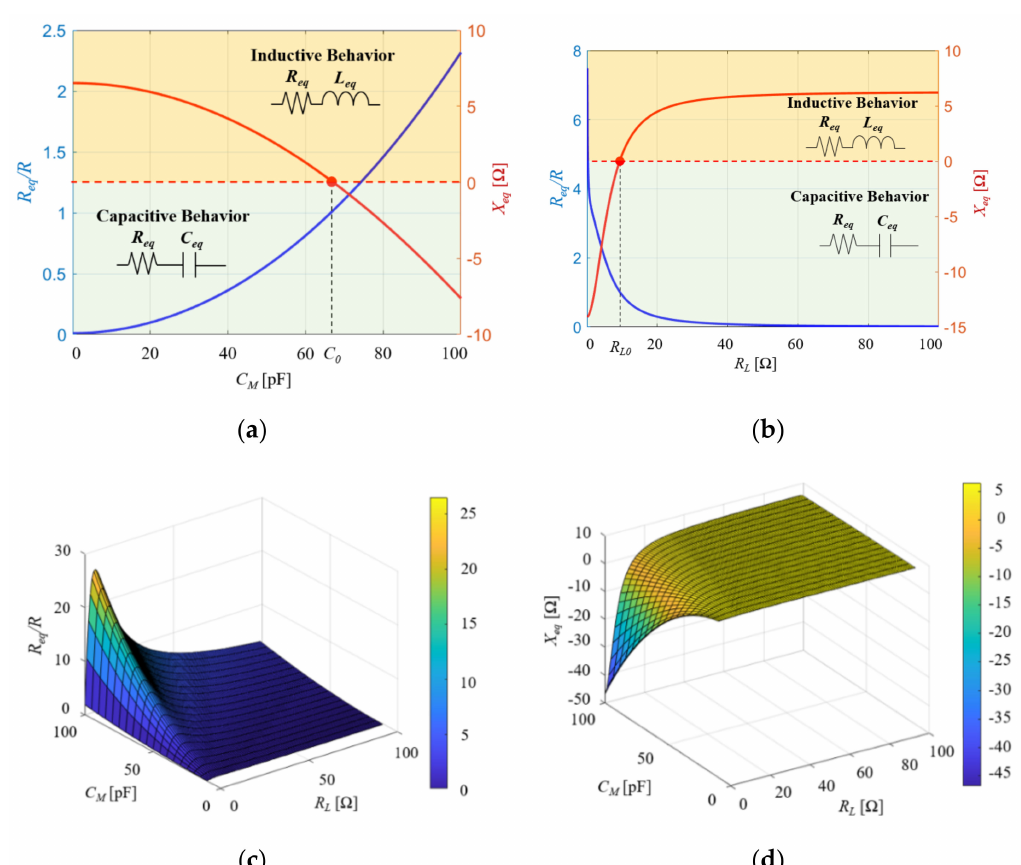
Figure 3. Equivalent impedance under capacitive coupling and load resistance variations. ( a ) Real and imaginary equivalent impedance part at fixed load resistance R L = 10 Ω and different coupling capacitance C M . ( b ) Real and imaginary equivalent impedance part at fixed load resistance C M = 32 pF. ( c ) The real part of the equivalent impedance. ( d ) The imaginary part of the equivalent